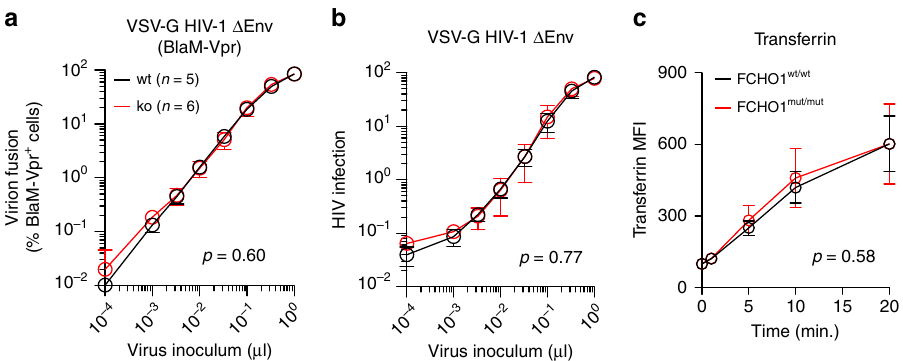
Fig. 5 FCHO1 de fi ciency does not alter global clathrin-mediated endocytosis. a , b Fusion of VSV-G HIV-1 Δ Env (BlaM-Vpr) virions ( a ) or infection by VSV-G HIV-1 Δ Env ( b ) of Jurkat cells. Wt or FCHO1-de fi cient clones were challenged with increasing volumes of the indicated VSV-G HIV-1 Δ Env. Virion fusion was monitored by fl ow cytometry as previously reported 29 – 31 and the percentage of cleaved CCF2 + /BlaM-Vpr + cells is plotted relative to the virus inoculum. Infection of VSV-G HIV-1 Δ Env was monitored by intracellular HIV-1 p24 staining two days post challenge and the relative percentage of p24- positive cells is plotted relative to the virus inoculum 32 . Arithmetic means and standard errors are shown of results obtained for the indicated number of clones from either virion fusion ( e ) or infection ( f ). c Patient fi broblast or healthy donor fi broblast were subjected to the transferrin uptake assay. Cells were exposed to fl uorescently labelled transferrin for the indicated time at 37 °C and subsequently analysed by FACS. Data are pooled of four independent assays; error bars represent standard deviation. a – c Statistical analysis was performed using two-way ANOVA ( p -values for the effect of the genotype). Source data are provided as a Source Data fi